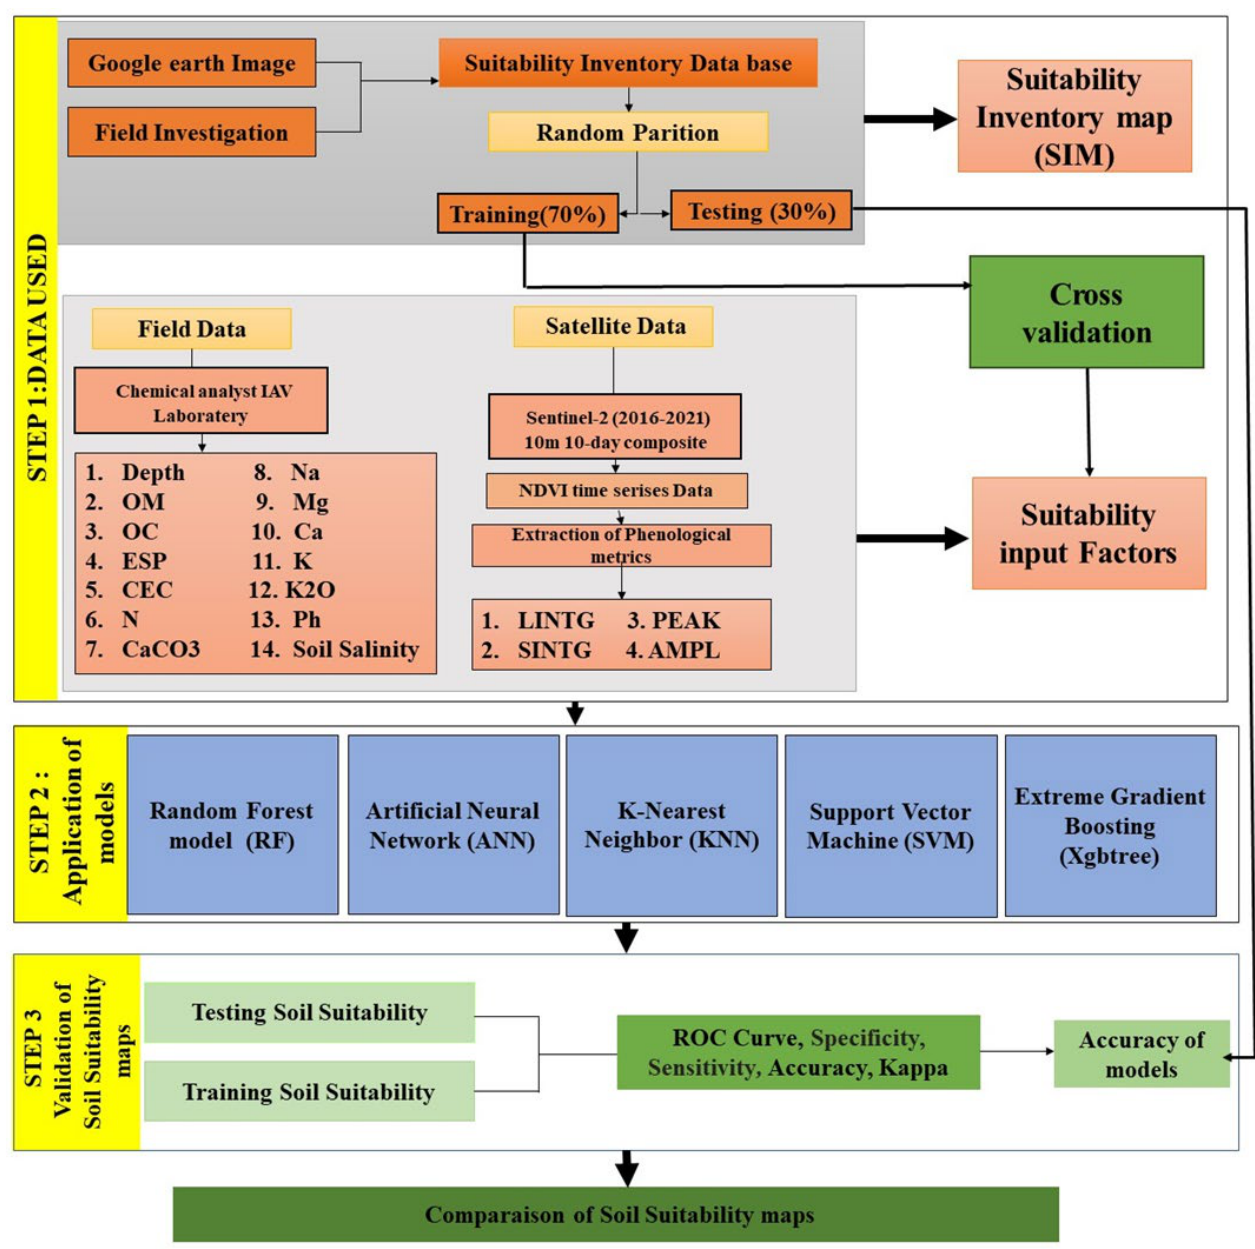
Figure 2. Flowchart of the methodology.